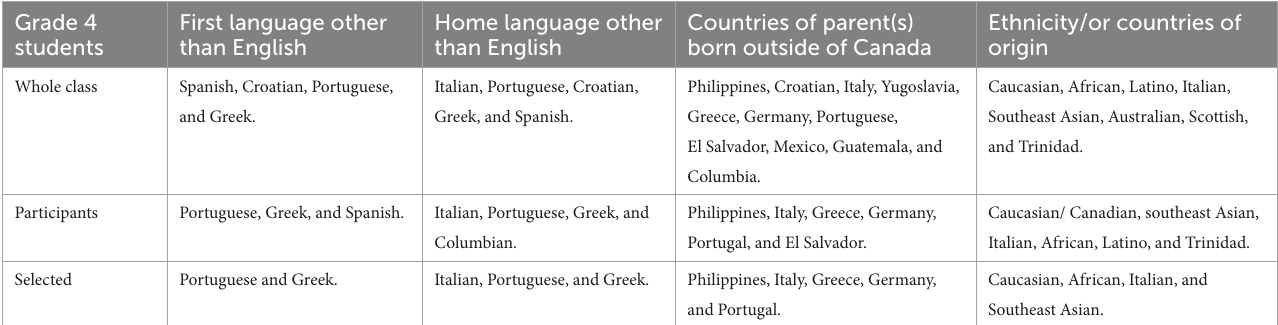
TABLE 2 Students’ linguistic and cultural